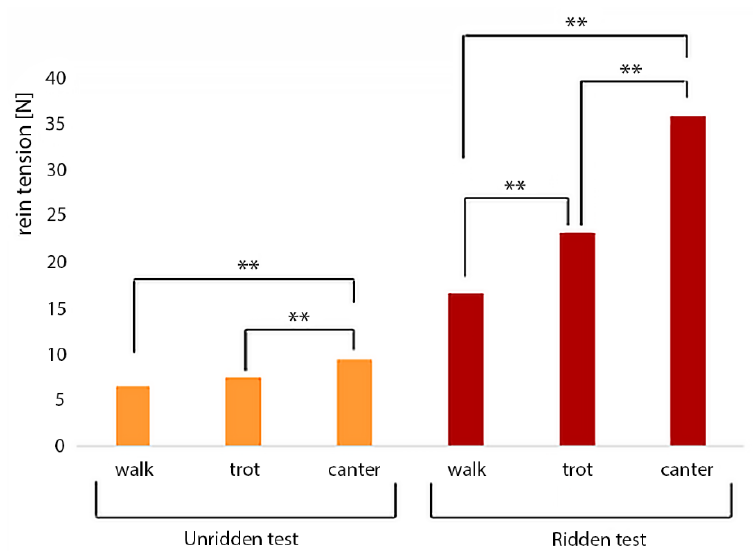
Figure 7. Mean values of the maximum rein tension of all horses in the di ff erent gaits; with a rider, the highest rein tension occurred during the canter (35.9 N ± 18.1 N) followed by the trot (23.2 N ± 14.1 N) and the walk (16.5 N ± 10.2 N); without a rider, rein tension was significantly higher during the canter (9.4 N ± 3.0 N) than the trot (7.4 N ± 3.2 N) as well as the canter and the walk (6.5 N ± 2.8 N), but not between walk and trot; ** indicates p < 0.01.